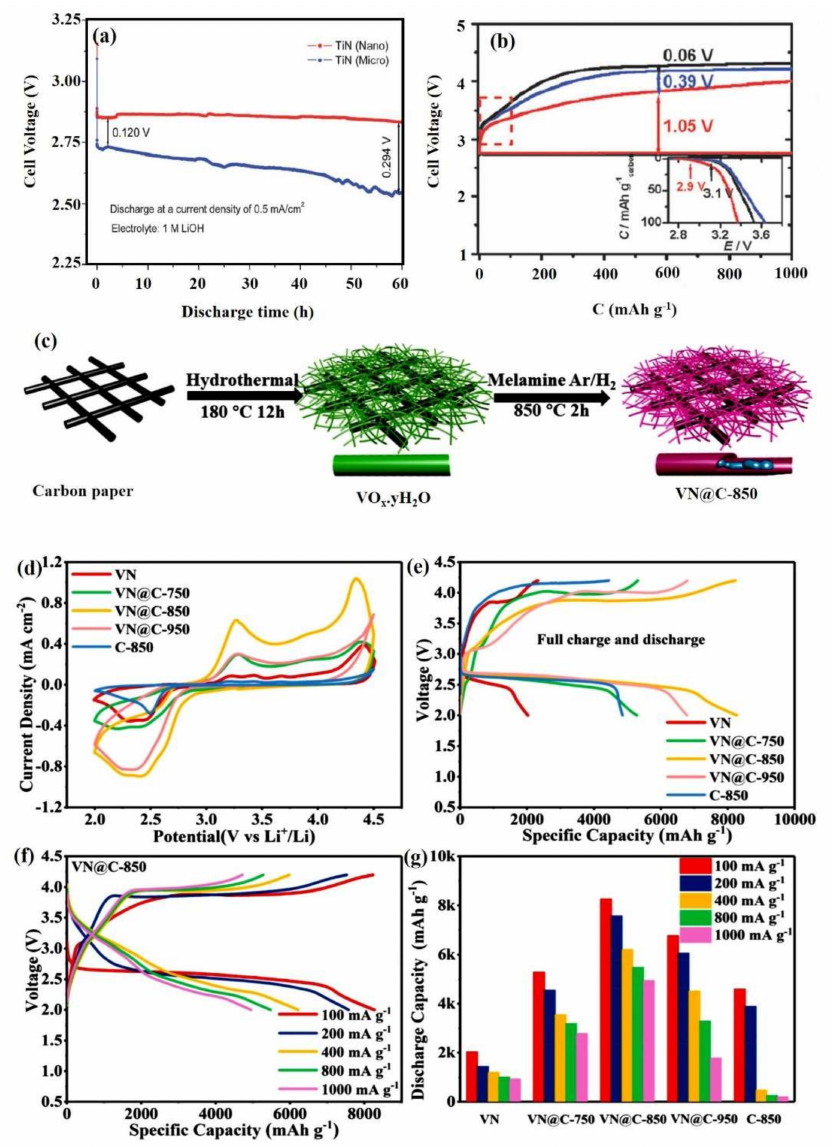
Figure 7. ( a ) Discharge plot for an LOB using TiN particles as a cathode catalyst [89]. Copyright 2012 The Royal Society of Chemistry. ( b ) Discharge plots for di ff erent TiN-based catalysts (m-TiN / VC and n-TiN / VC) and pristine VC (inset) @ 50 mA g carbon − 1 [93]. Copyright 2013 The Royal Society of Chemistry. ( c ) Graphical illustration of the fabrication method for a VN@C-850 catalyst. ( d ) CV curves for VN, C-850, and VN@C at various calcination temperatures at 0.3 mV s − 1 in the voltage range between 2.0 and 4.5 V. ( e ) Corresponding GCD plots ( f ) GCD curves for VN@C-850 at various current densities. ( g ) Discharge specific capacity of the cathode catalysts at various discharge rates